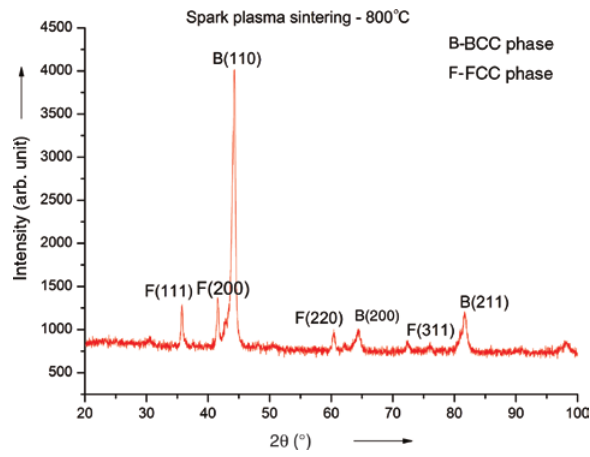
Figure 3: XRD patterns of AlMgNiCrTi HEA after SPS at 800 °